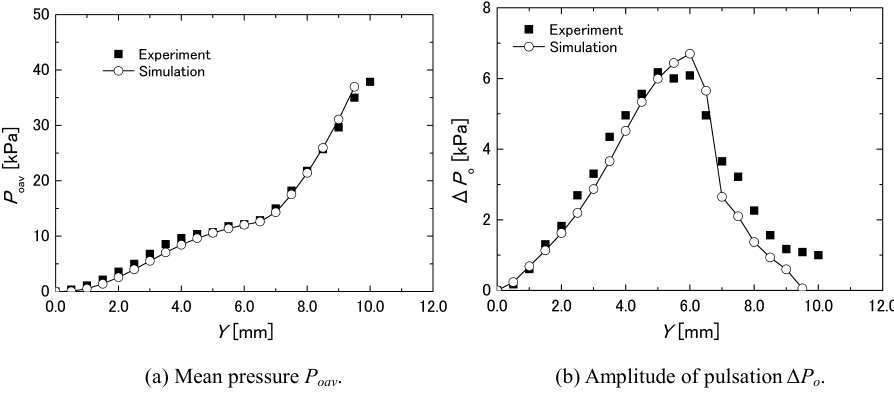
Fig. 11 Pressure pulse waves obtained by numerical simulation with the parameters shown in Table 2.